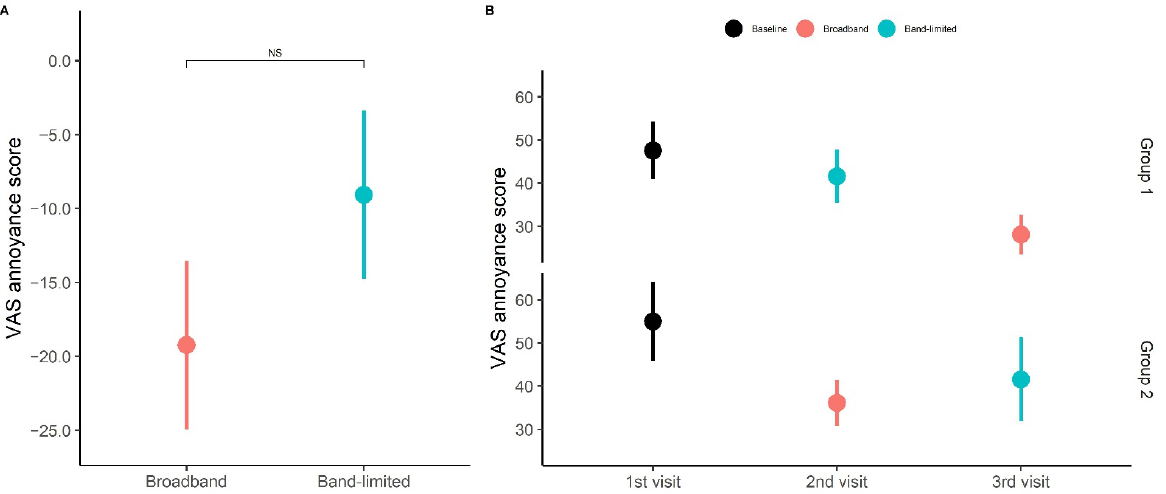
Figure 6. Tinnitus annoyance. ( A ) Average change in VAS annoyance score after broadband and band-limited amplification compared to the baseline. The data from groups 1 and 2 were pooled for both the broadband and band-limited conditions. Averages are presented as mean ± SEM. ( B ) Average VAS annoyance score at each visit subdivided into treatment groups.